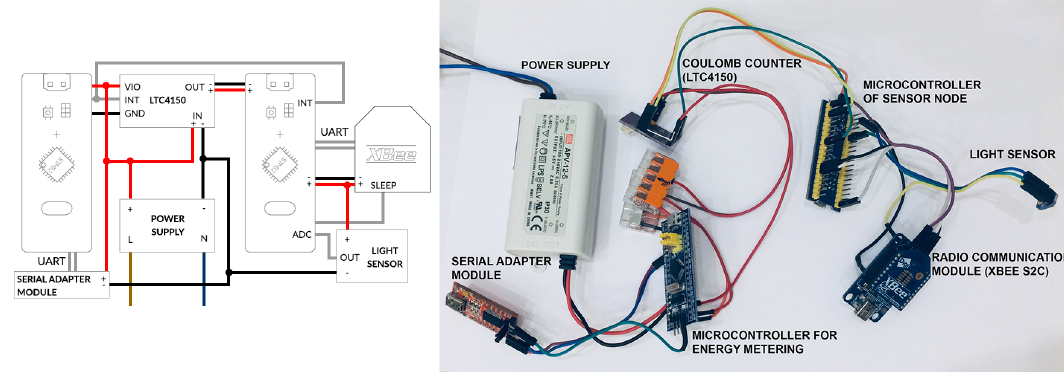
Figure 3. Part of experimental testbed for one sensor